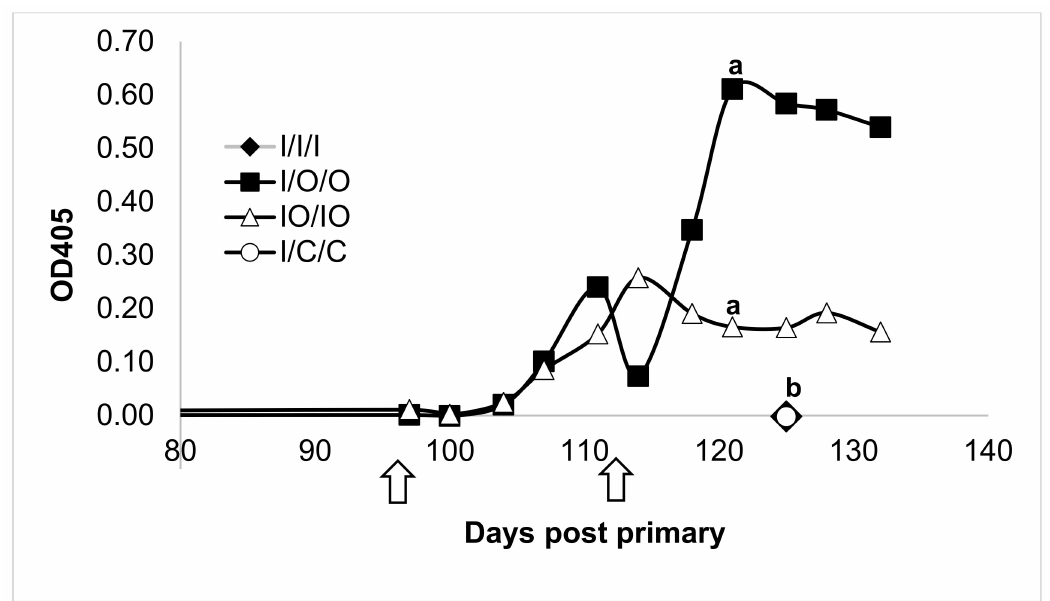
Figure 1. Fecal IgA response to injected, oral, or co-administered injected / oral HBsAg treatments. Mice were administered (i) three injected doses (I / I / I), (ii) injected primary followed by two oral boosts (I / O / O), (iii) co-administered injected and oral dose for the primary and first boost (IO / IO), or (iv) an injected primary followed by two control oral boosting doses (I / C / C). Black arrows represent times of boosting. Only oral treatments elicited a detectable response. Letters above the trendlines represent statistical analysis of the responses. Treatments with di ff erent letter designations are significantly di ff erent while treatments with the same letter designation fail to show a statistically significant di ff erence.